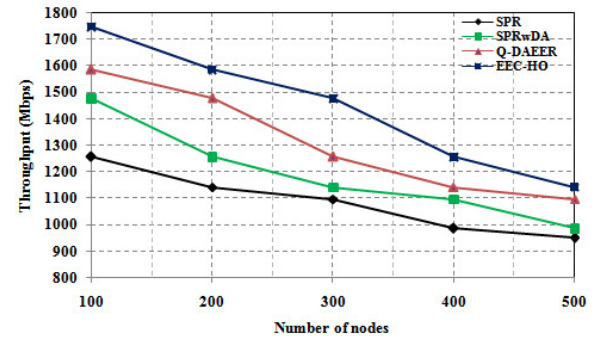
Figure 5. Throughput with number of nodes